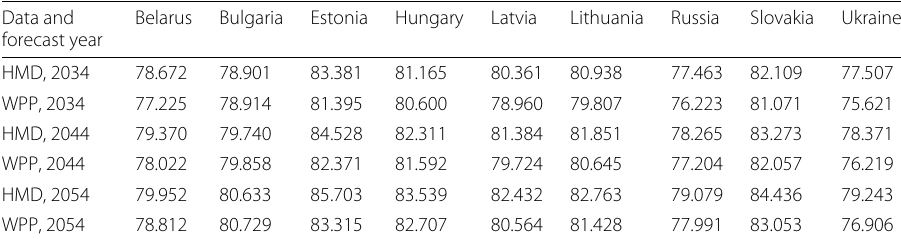
Table 10 Forecast of life expectancies at birth using UN forecast method for HMD-2018 and WPP-2012